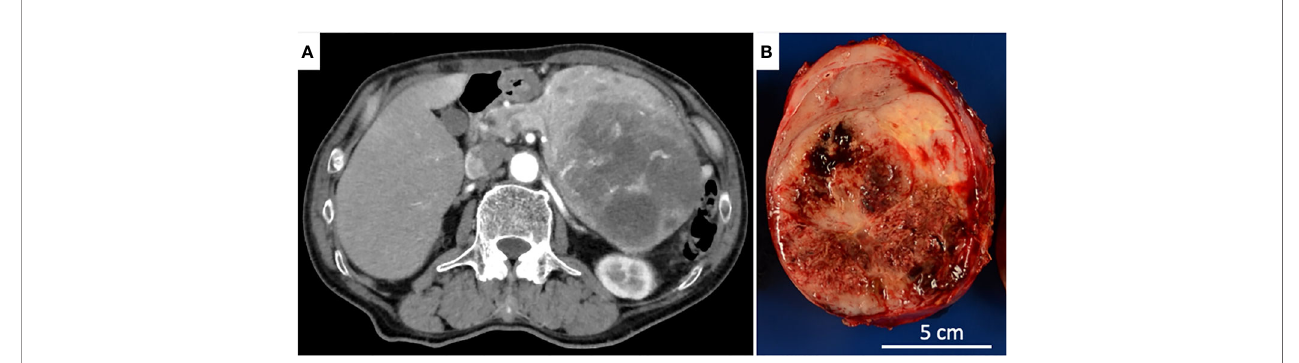
FIGURE 1 | (A) Axial CT revealed an expansile, solid tumor largely degenerated with necrosis in the dorsal part. (B) The cut surface of the pancreatic tail tumor showed a well-circumscribed, lobulated, solid tumor with a large hemorrhagic, necrotic